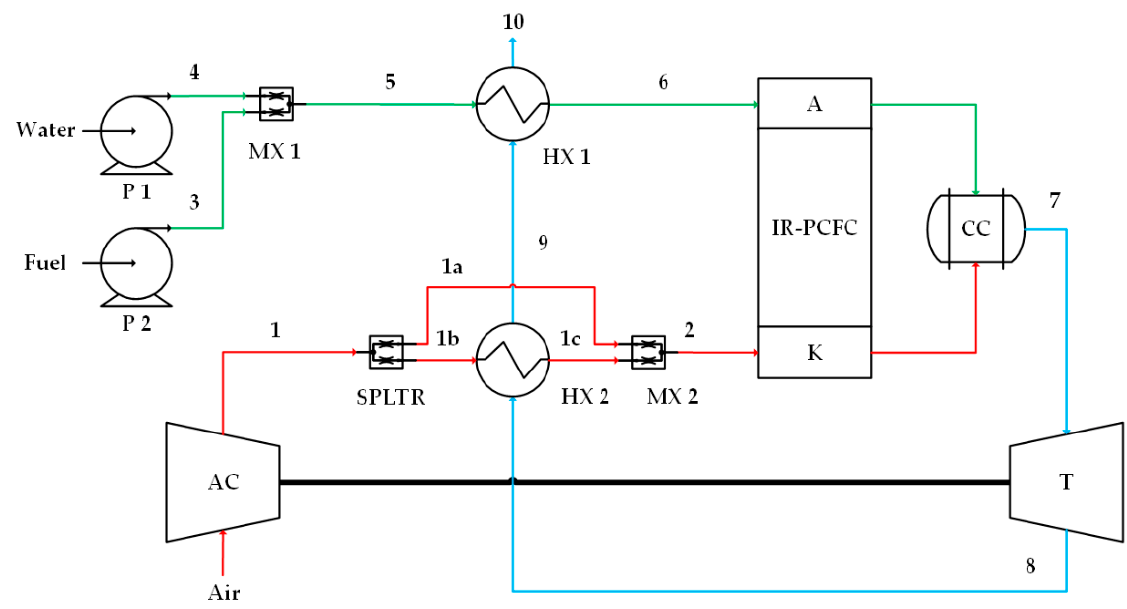
Figure 2. Case 2, high‑quality heat from turbine flows into the cathode preheater (HX2). Numbers 1, 1a, 1b, 1c and 2 on the red lines indicate cathode flow, numbers 3, 4, 5 and 6 on the green lines indicate anode flow, and numbers 7, 8, 9 and 10 on the blue lines indicate combustion flow.